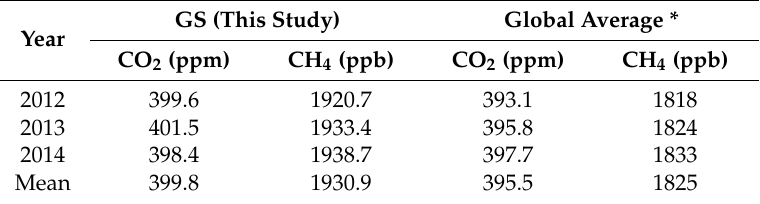
Table 1. Annual average CO 2 and CH 4 concentrations for the 2012–2014 period at the Ganseong (GS) site and global